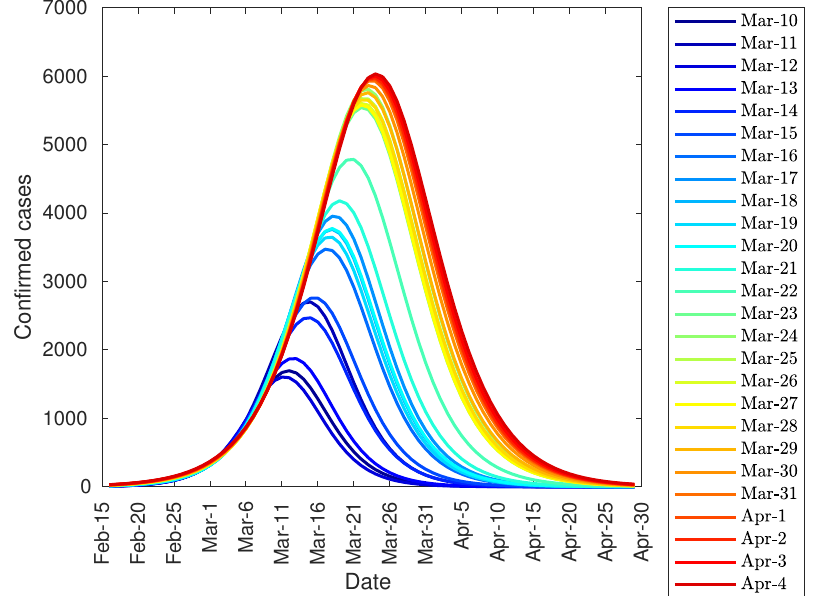
Figure 6. Evolution of the peak of diagnosed COVID-19 patients in Italy.